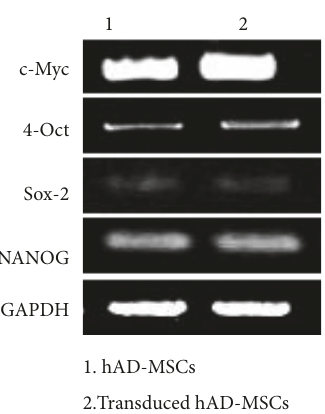
Figure 6: Stemness markers expression in hAD-MSCs and transduced